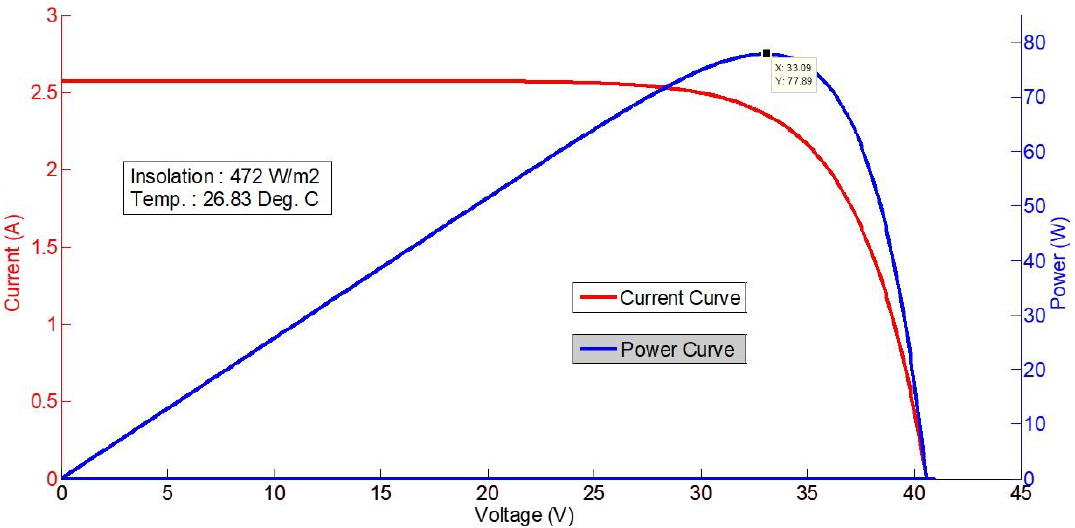
Figure 13. I-V and P-V characteristic of PV array at 10:00